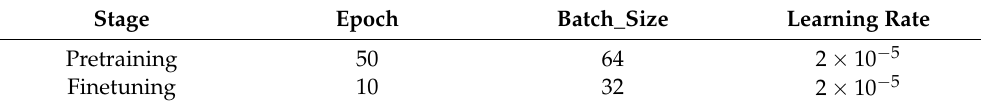
Table 1. Hyperparameter settings for our proposed model. Stage Epoch Batch_Size Learning Rate Pretraining 50 64 2 × 10 − 5 Finetuning 10 32 2 × 10 −